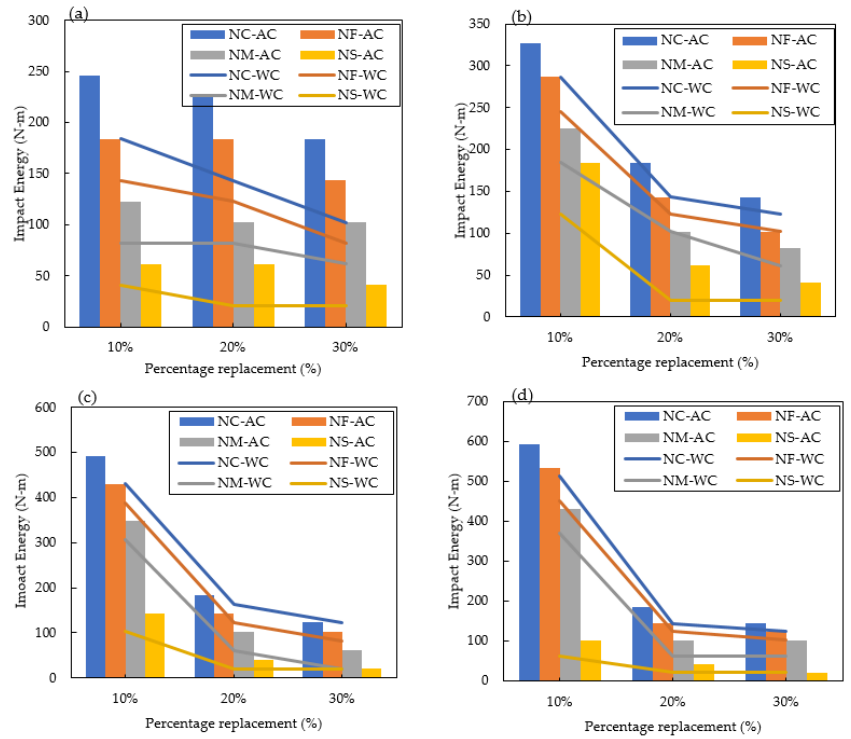
Figure 8. Impact energy versus percentages of nanomaterials in various grades at 500 °C: ( a ) M20; ( b ) M30; ( c ) M40; ( d ) M50.